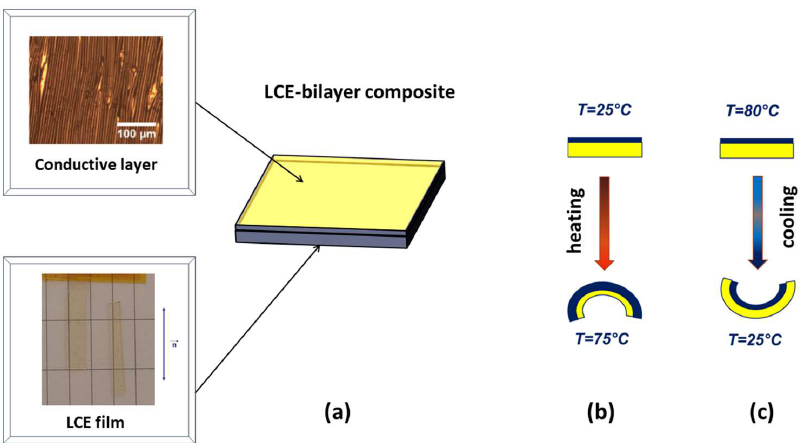
Figure 15. ( a ) Scheme of the LCE-based bilayer composites made using monodomain side-chain LCE films and a nanostructured conductive layer [92,93]. Different temperature-induced bending geometries of the LCE-based bilayers depending on the temperature of deposition of the conductive layer: ( b ) T << T N-PN (T = 25 ◦ C), LCE in the nematic (ordered) phase; and ( c ) T > T N-PN (T = 80 ◦ C), LCE in the paranematic or isotropic (disordered)